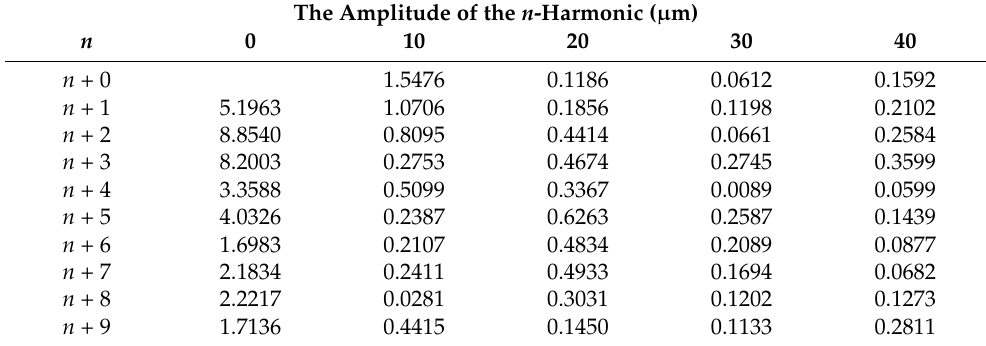
Table 2. Values of the amplitudes of the harmonic components of the measured summary profile. The Amplitude of the n -Harmonic ( μ m)